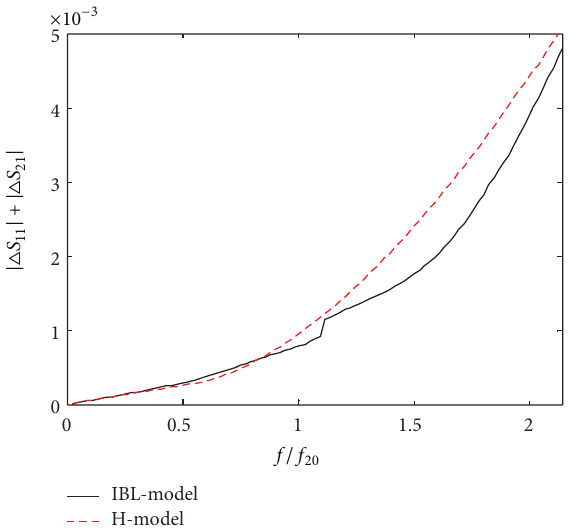
Figure 7: The 𝑆 -parameter differences at 𝜃 0 = 30 ∘ for the H- and IBL-models with parameters retrieved at normal incidence.